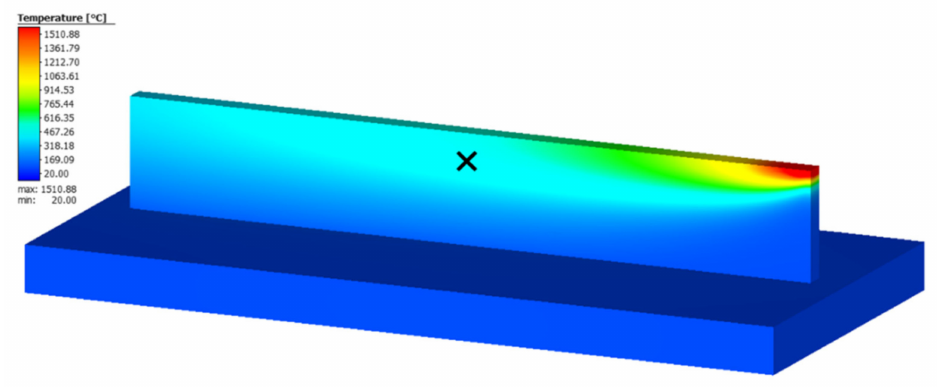
Figure 14. Temperature field in the welding simulation for wall structure (length 300 mm) and energy input per unit length 8 kJ/cm with layer